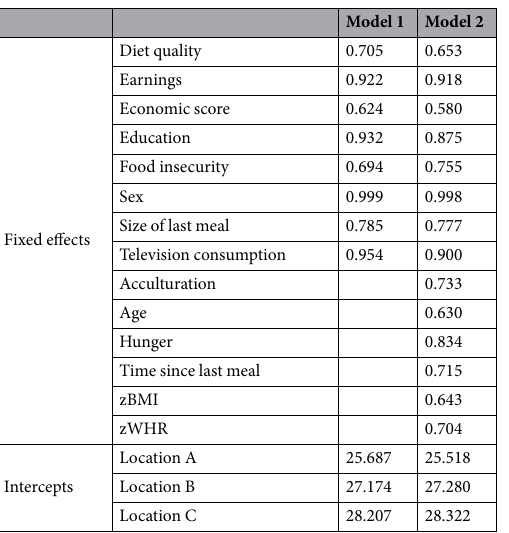
Table 3. Effect size and intercept estimates for both mixed effect linear models. Fixed effect estimates show un- signed percentage probability mass for effect size away from the null line for ease of comparison. See Fig. 2 for directional